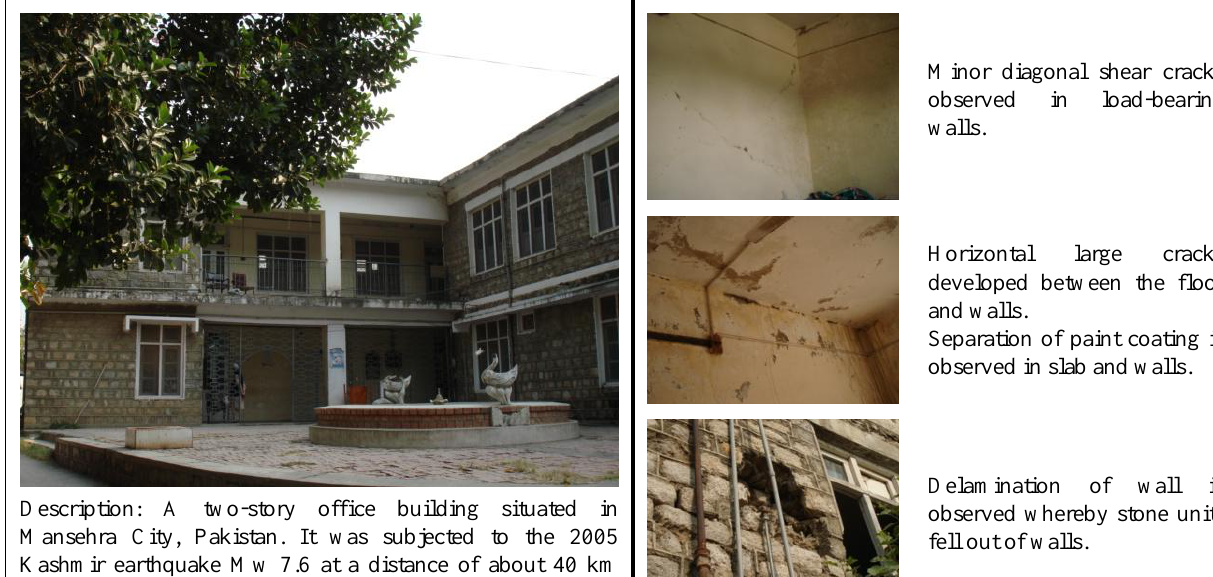
Fig. 2. A moderately damaged half-dressed stone DS masonry structure. From left to right: view of the building and description of the observed main damages in the